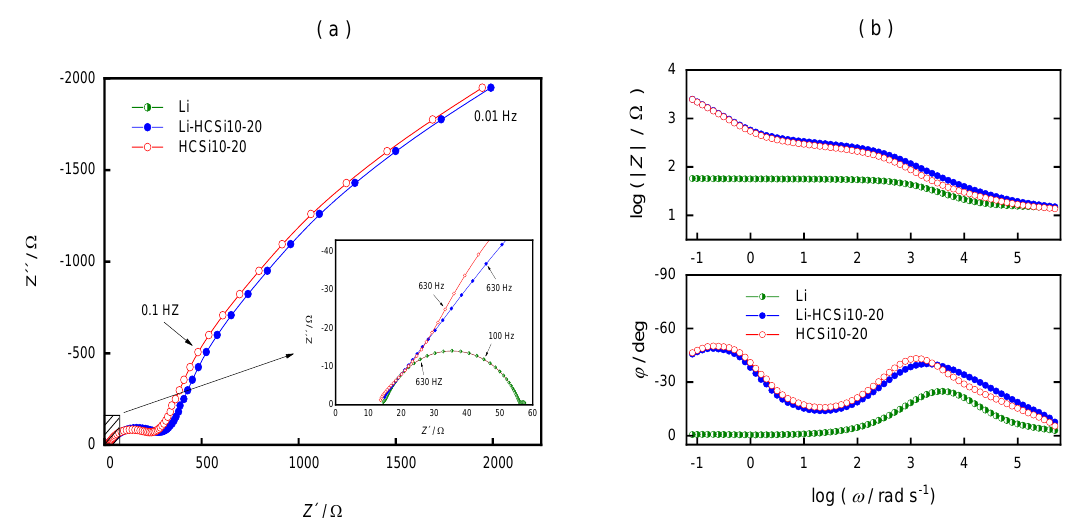
Figure 11. Impedance spectra of symmetric cell (Li-Li) at OCP 0.0 V and asymmetric cell. (Li-HCSi20) at OCP +3.5 V in ( a ) Nyquist plot, ( b ) Bode plot.